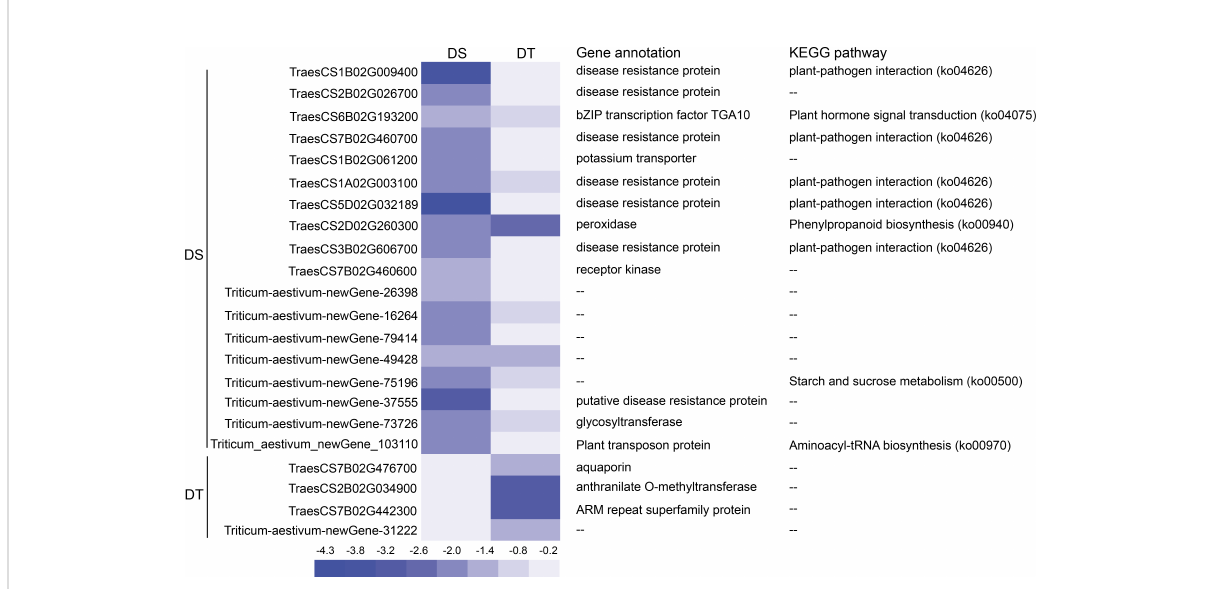
FIGURE 6 Heatmap of the expression of DEGs in lncRNA-miRNA-mRNA regulatory modules and their functional annotations. DS, drought-sensitive variety JM38, DT, drought-tolerant variety